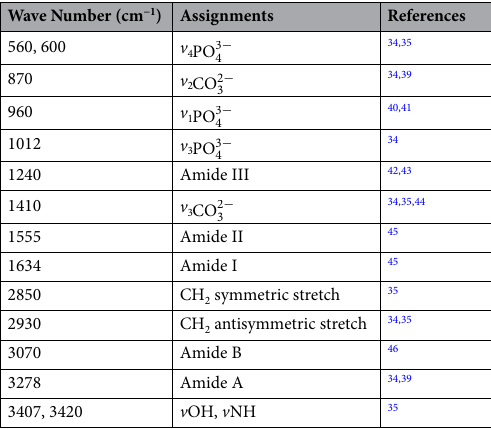
Table 2. Fourier transform infrared spectroscopy absorption bands for bone and their functional groups.